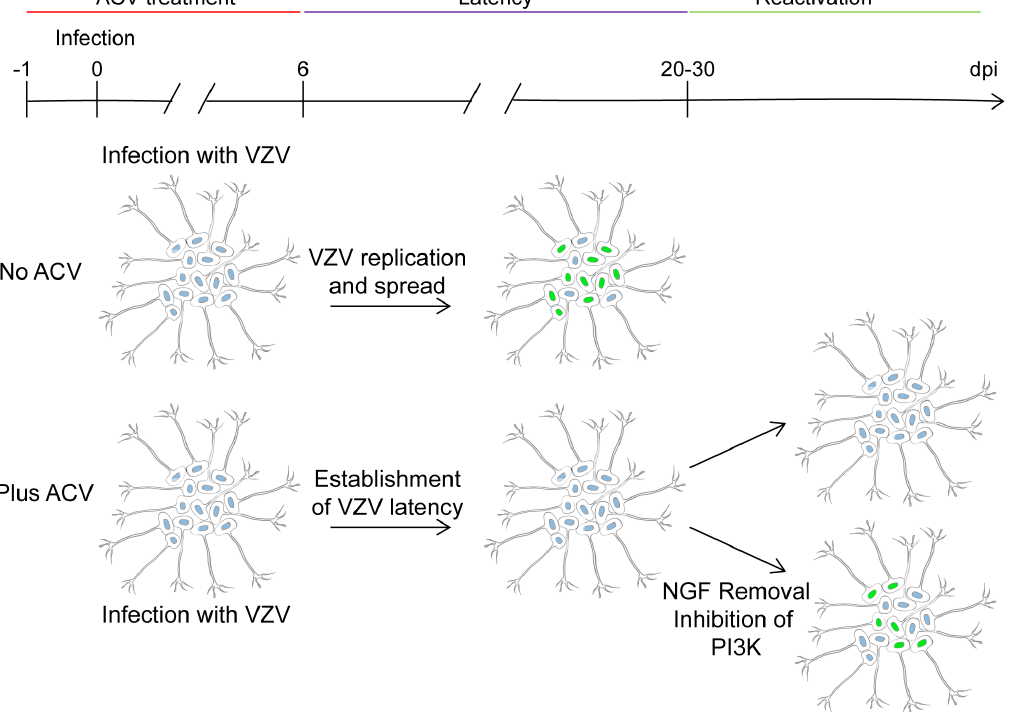
Figure 2. Schematic representation of the acyclovir (ACV) model to study VZV latency and reactivation (based on [74]). Addition of ACV to PSC-derived human neurons prior to infection followed by six days ACV incubation during VZV infection results in the establishment of a latent phenotype characterized by low level gene expression, no detectable protein expression and lack of infectious VZV during several weeks upon ACV removal. Infection is not abortive since VZV reactivates following removal of nerve growth factor (NGF) or inhibition of phosphoinositide 3-kinase (PI3K). In the original submission the authors used VZV expressing open reading frame 66 fused to green fluorescent protein, permitting the detection of infected neurons by direct fluorescence. Abbreviation: dpi, days